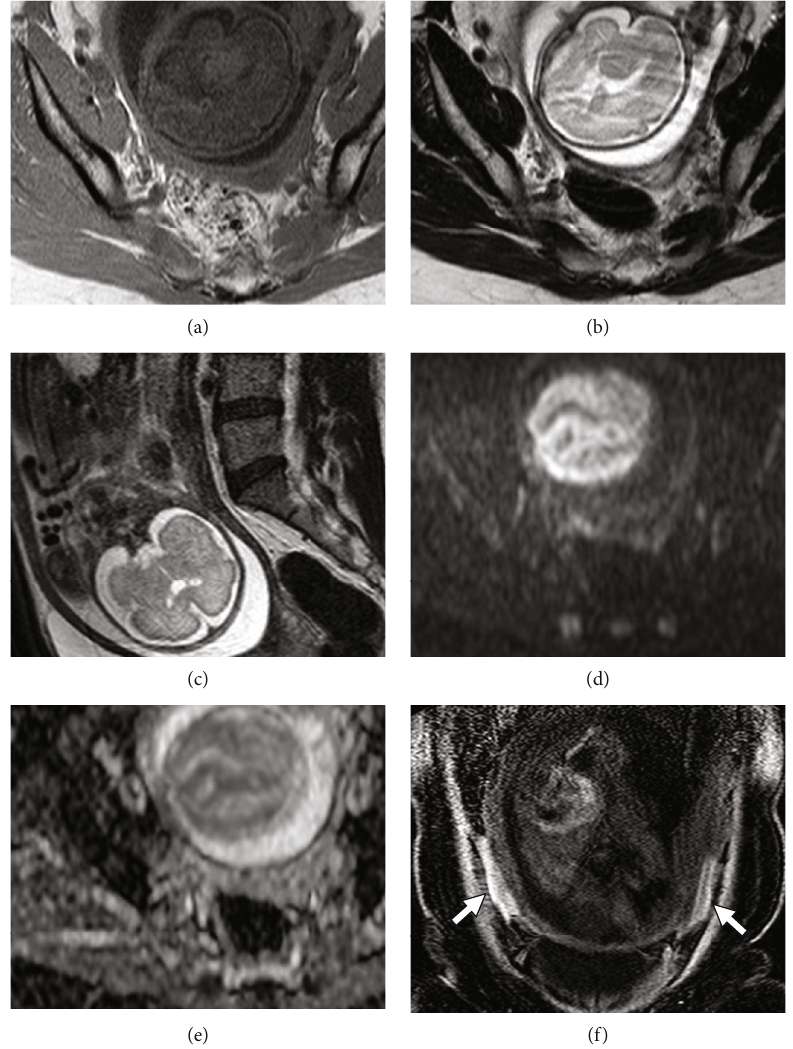
Figure 2: Magnetic resonance imaging (MRI) of the pelvis performed at 27 weeks of gestation. (a) Axial T1-weighted image. (b) Axial T2-weighted image. (c) Sagittal T2-weighted image. (d) Axial di ff usion-weighted image (b factor: 1000s/mm 2 ). (e) ADC map. (f) Coronal T1-weighted image with fat saturation. The cystic lesion disappears (a – e). Ascites around the uterus shows high signal intensity on fat-suppressed T1-weighted images, which is consistent with bloody ascites (f, arrows). Based on serial MRI fi ndings, rupture of the decidualized ovarian endometrioma is suspected.